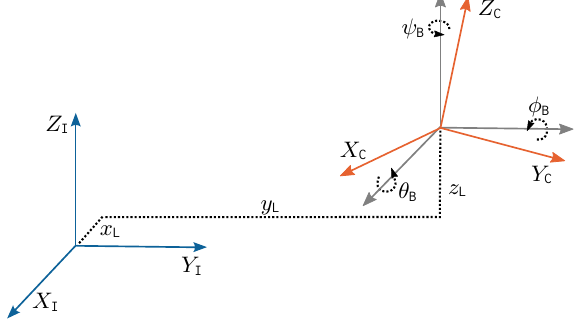
Figure 2: The rigid mounting of a camera and an INS induces static offsets between the underlying coordinate systems denoted by C and I. More precisely position offsets x L , y L and z L as well as angle misalignments, here visualized in form of Euler angles yaw = ψ B , pitch = θ B and roll = φ B , arise. These have to be determined in an INS-camera